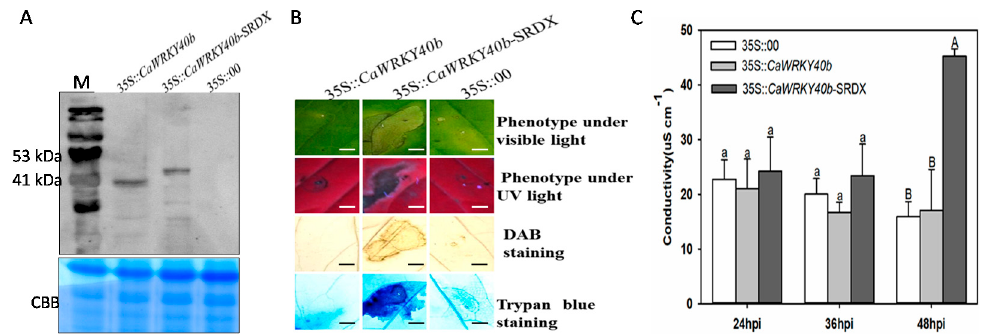
Figure 4. The transient overexpression of CaWRKY40b -SRDX triggers extensive HR cell death in pepper leaves. ( A ) The transient overexpression of CaWRKY40b -HA-SRDX and CaWRKY40b -HA in pepper leaves was detected by immune-blotting (IB) against the antibody of HA. CBB, Coomassie brilliant blue. ( B ) Intensive cell death was triggered by transient overexpression of CaWRKY40b -SRDX, but not by that of CaWRKY40b and displayed by phenotype, DAB, and trypan blue staining at 4 dpi, respectively. Bar = 100 µm. ( C ) Quantification of electrolyte leakage as ion conductivity to assess the cell death response in leaf disks, the means ± SD were calculated from four samples, each containing six disks. Capital and lowercase letters above the bars indicate significant difference at p < 0.01 and p < 0.05, respectively, as analyzed by Fisher’s protected LSD test.